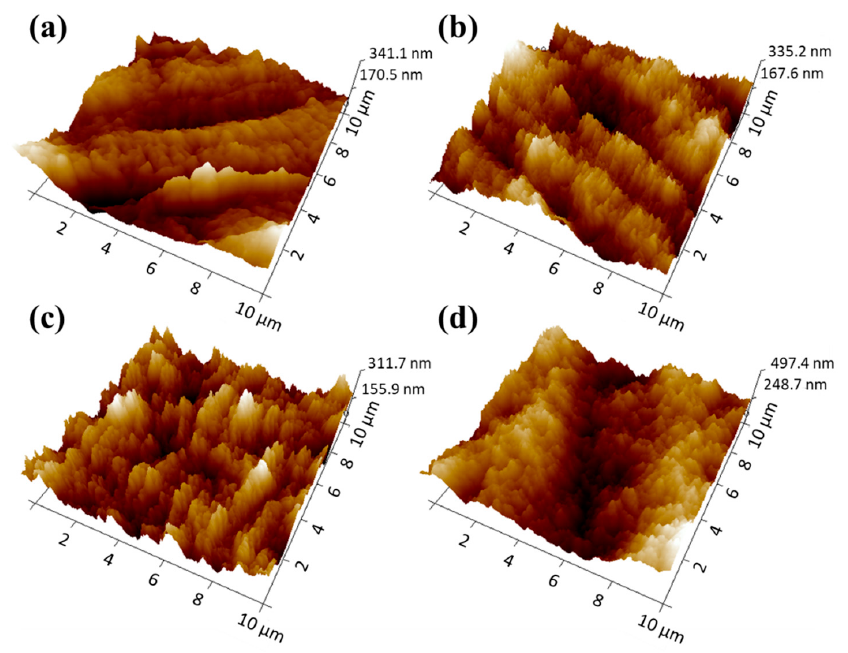
Figure 5. AFM images of UHMWPE before plasma treatment ( a ), with plasma treatment for 1 min ( b ), 2 min ( c ) and 5 min ( d